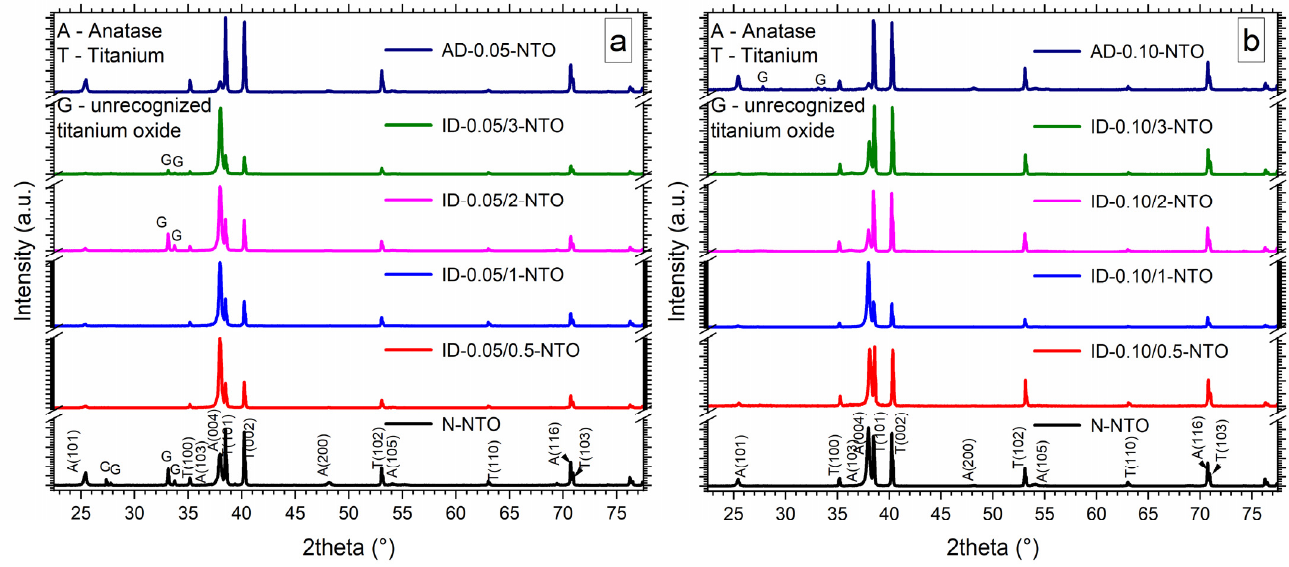
Figure 2. X-ray diffraction (XRD) patterns of nickel-doped nanostructured titanium oxide coatings obtained by anodizing for 40 min at 30 V for the sets of samples ( a ) N-NTO, ID-0.05/y-NTO, AD- 0.05-NTO, and ( b ) N-NTO, ID-0.10/y-NTO, AD-0.10-NTO.